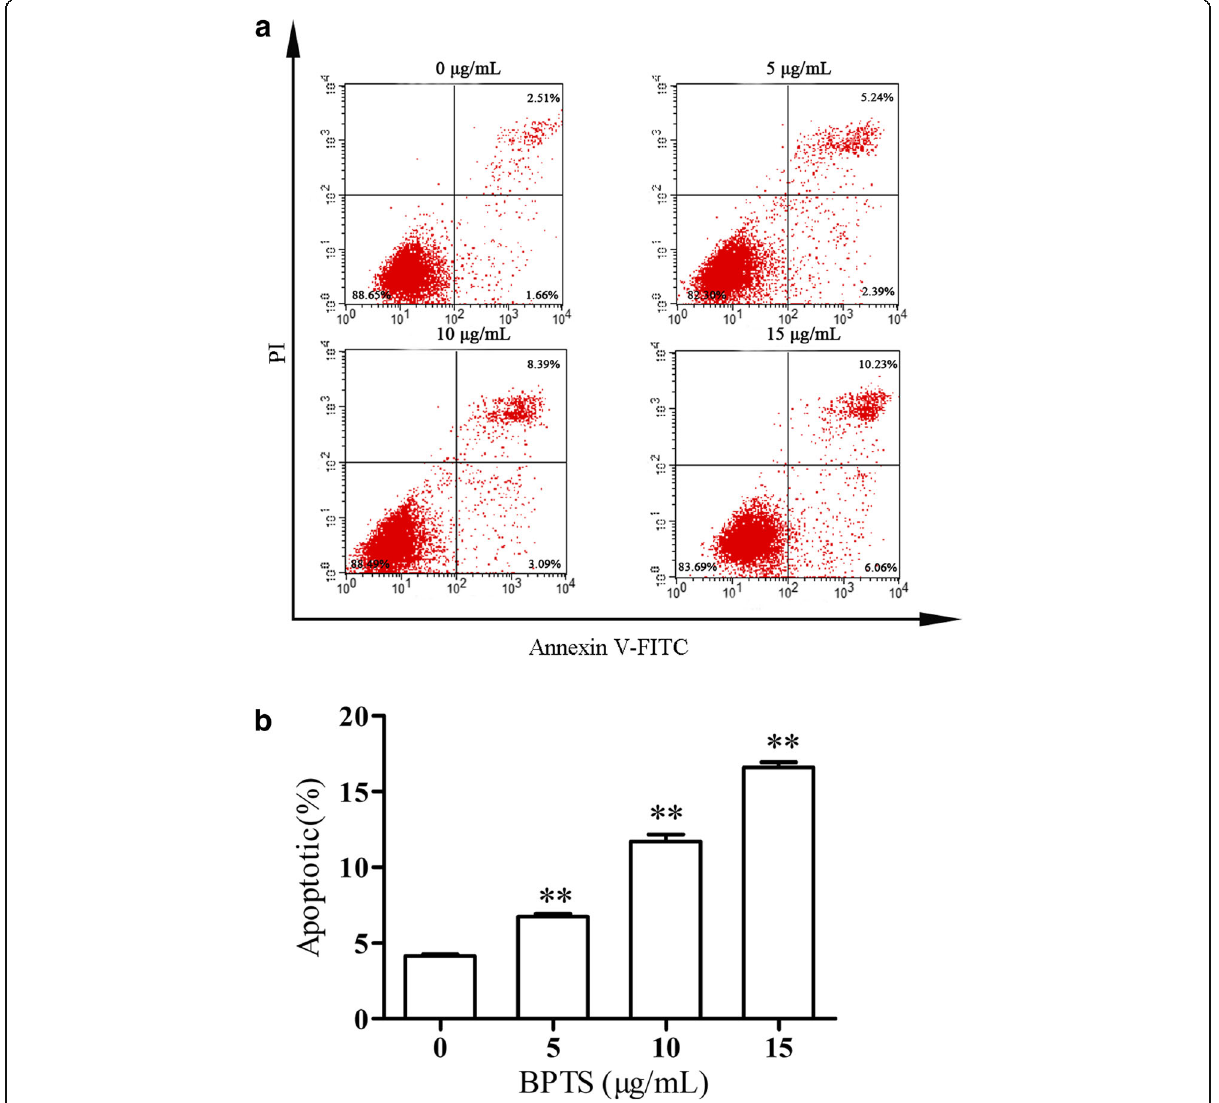
Fig. 2 Flow cytometry analysis of apoptosis in MDA-MB-231 cells. a Representative images of flow cytometry. b Apoptotic rates in cells treated with the stated concentrations of BPTS. ** P < 0.01 vs. 0 μ g/mL of